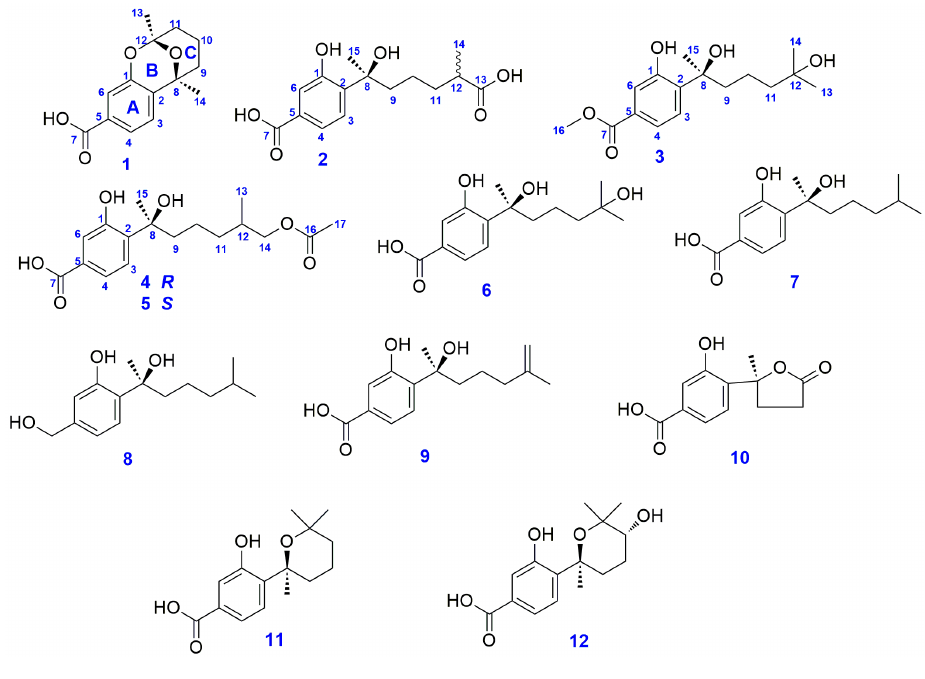
Figure 1. Thestructures of compounds 1 – 12 .